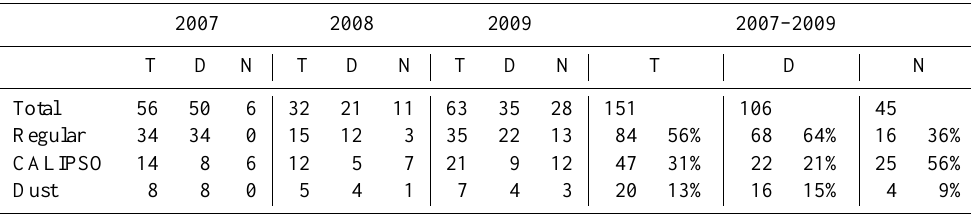
Table 1. Number of measurements performed and inverted satisfactorily during the period 2007–2009, T, D and N indicate, respectively, Total, Day and Night.